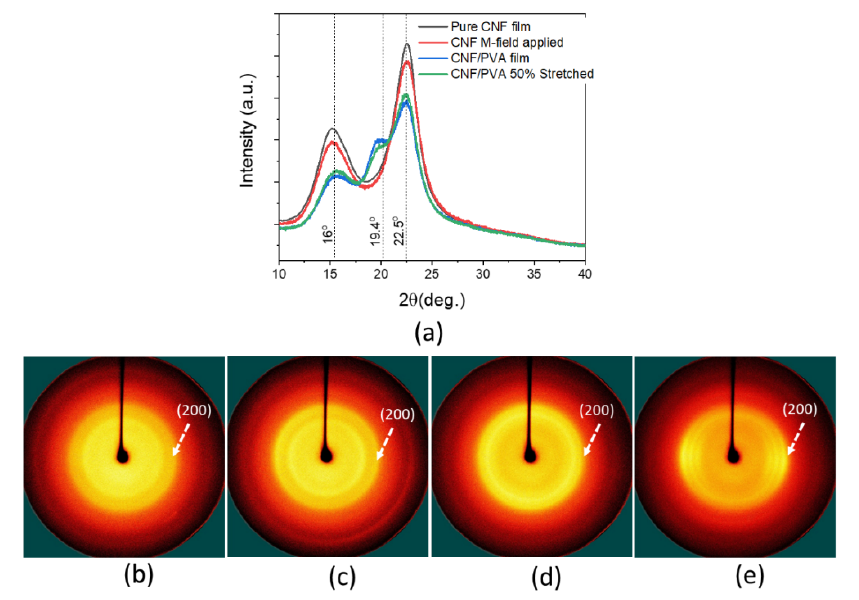
Figure 7. ( a ) XRD patterns of CNF and CNF/PVA films; 2-D WAXD patterns of ( b ) the pure CNF film; ( c ) the CNF film under M-field; ( d ) the pure CNF/PVA film, ( e ) the 50% stretched CNF/PVA film.